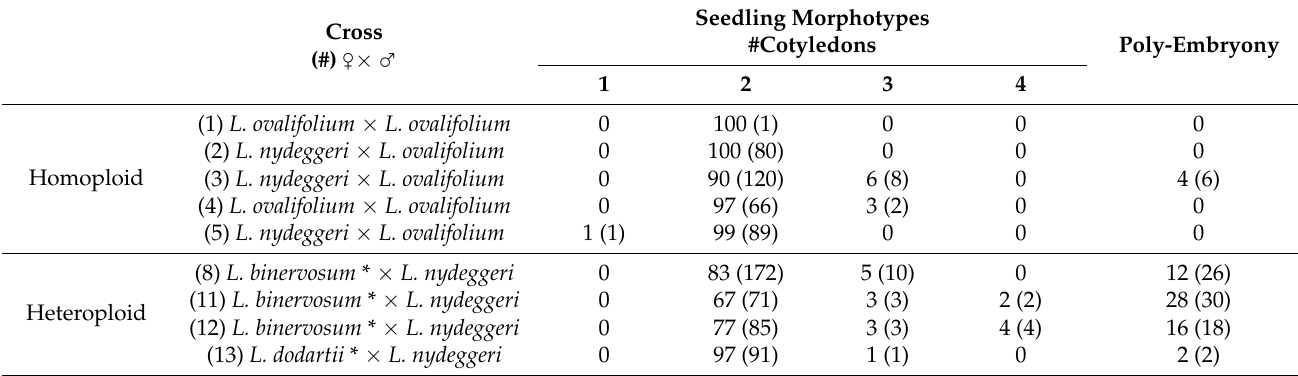
—female recipient; —male ♀ ♂